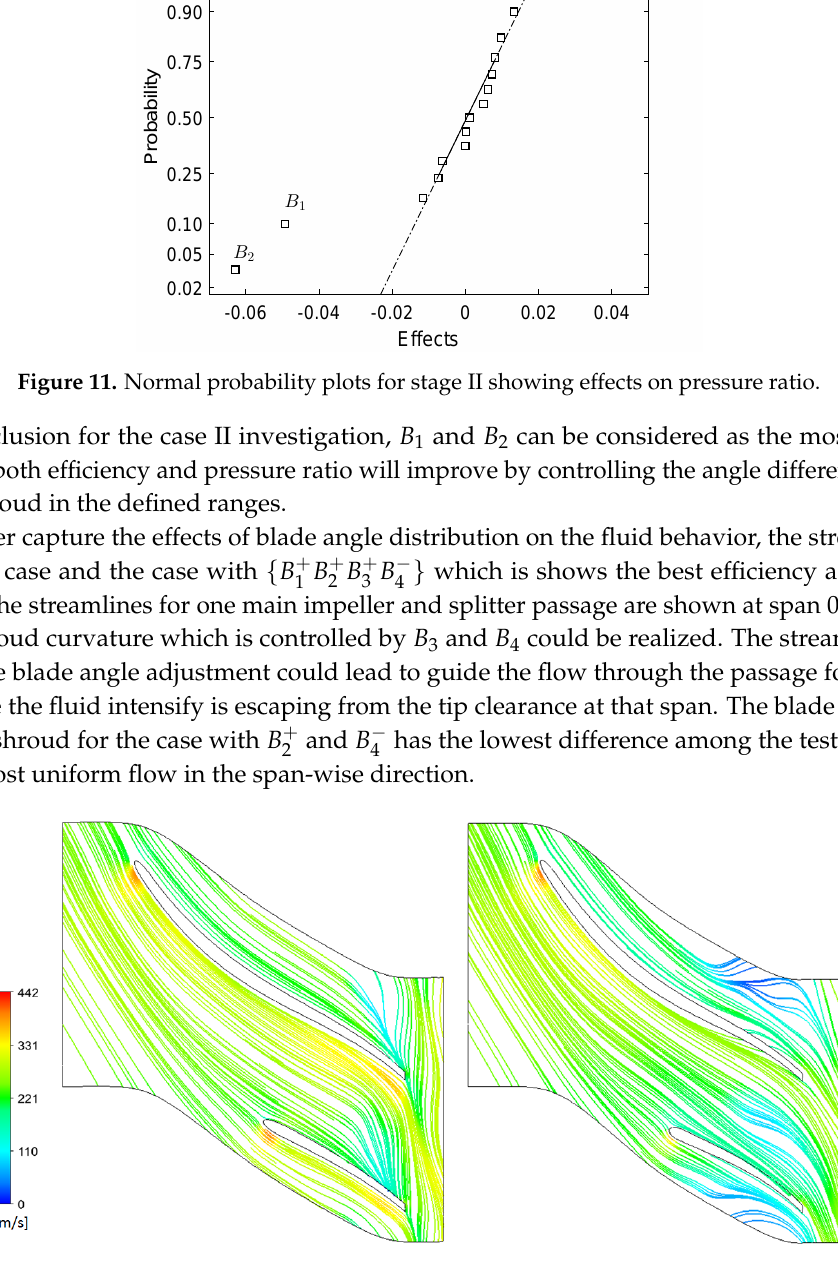
Figure 12. Streamlines of the original case (left) versus case { B +